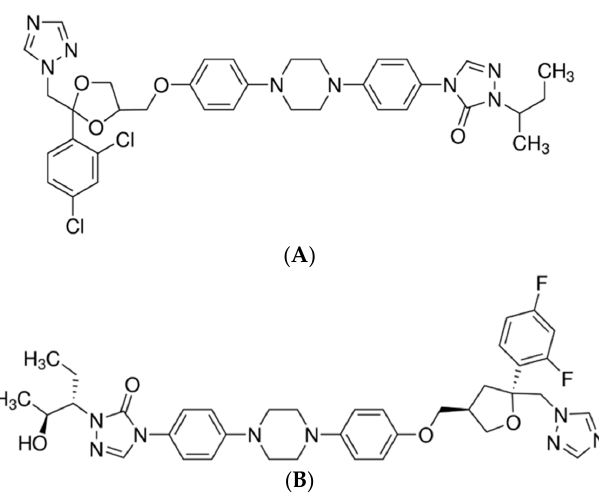
Figure 1. Structure of studied biocides: ( A ) itraconazole, ( B ) posaconazole.